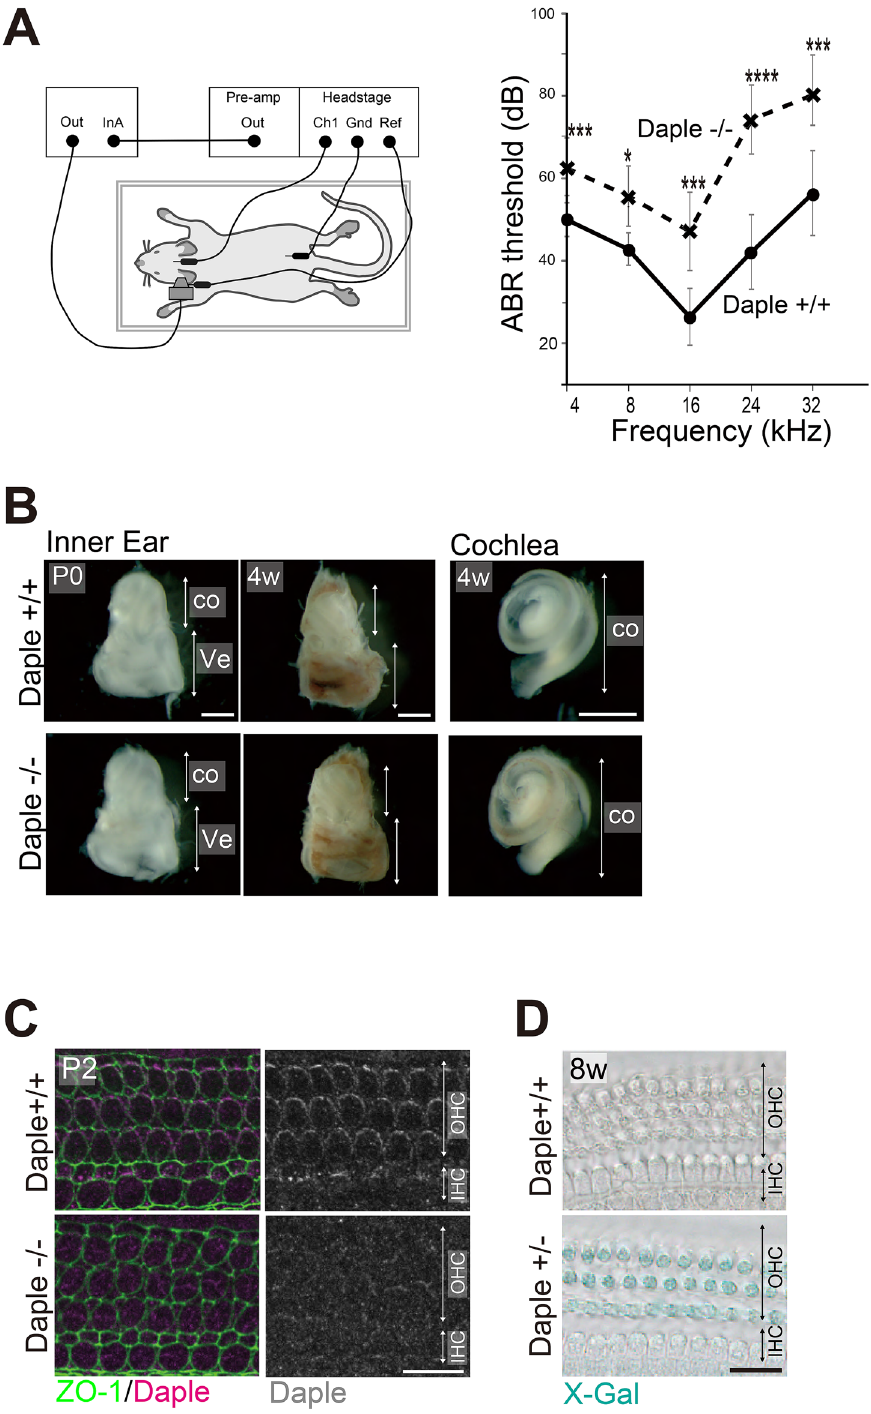
Figure 1. Hearing ability, inner ear morphology, and Daple expression in Daple-deficient mice. ( A ) The auditory brainstem response (ABR) thresholds of Daple −/− mice (8–12-week-old, n = 7) were significantly higher than those of Daple +/+ mice (8–12-week-old, n = 7; p < 0.05). At around 24 kHz, ABR thresholds were significantly higher than in control mice ( p < 0.003). * p < 0.05, *** p < 0.005, **** p < 0.003. ( B ) The gross shape and length of the cochlear duct in the inner ears of Daple +/+ and Daple −/− mice (postnatal day (P)0, 4-week-old) seemed normal. ( C ) Immunostaining of the OC in wild-type P2 HCs from middle cochleae. Daple was stained on the lateral side of OHCs and IHCs. Additionally, some staining of centrioles was evident in HCs. The enrichment was not visible in Daple −/− littermates. HC, hair cell; OHC, outer hair cell; IHC, inner hair cell. ( D ) Daple promotor activity could be detected by the intensity of X-Gal staining as the LacZ gene was expressed as a fusion protein with exons 1–3 of Daple gene in Daple + /- mice. LacZ-Xgal staining revealed expression patterns of Daple in adult Daple +/− and Daple +/+ mice from middle cochleae. Daple +/− OHCs are stained blue. Scale bars: B; 1 mm, C; 10 μm, D; 20